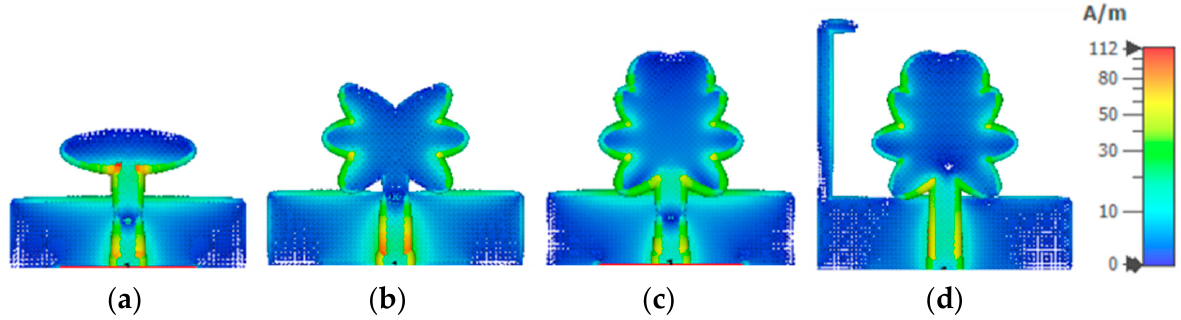
Figure 2. Evolution of the proposed antenna ( a ) first stage ( b ) second stage ( c ) third stage ( d ) fourth stage.